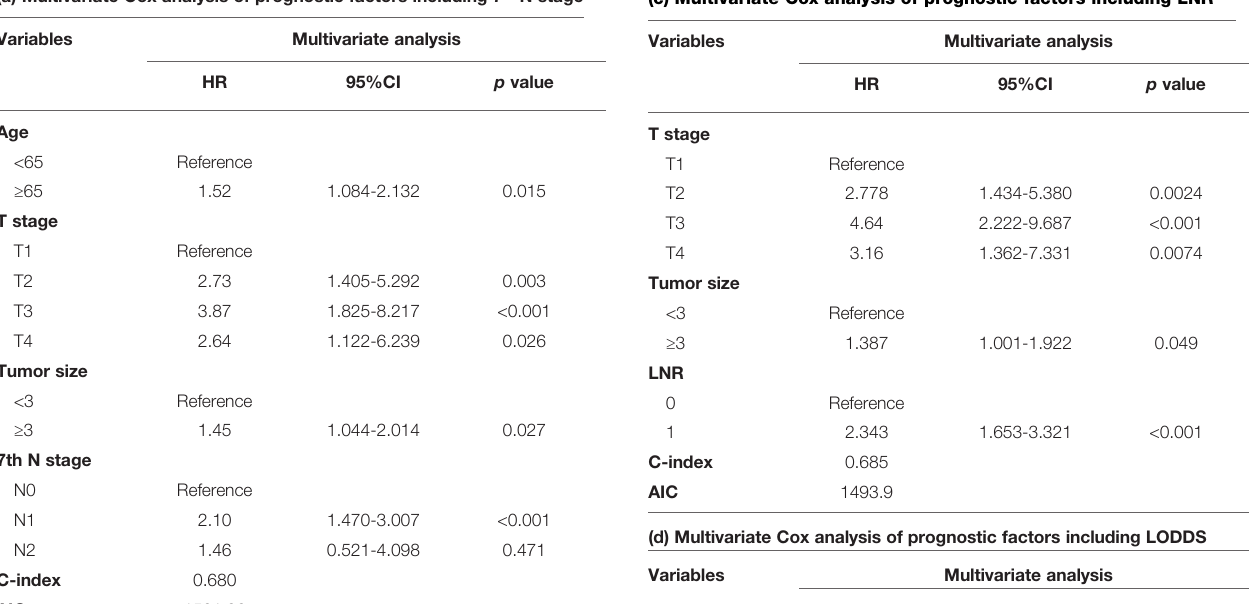
TABLE 4 | Evaluation of four models.